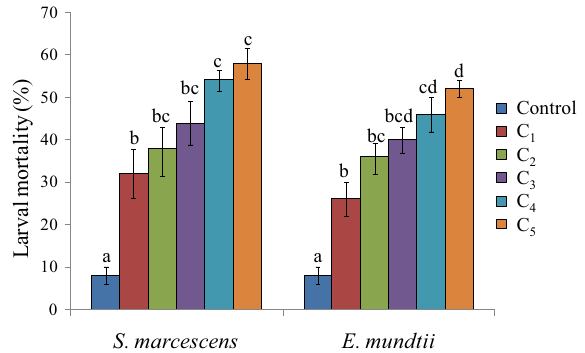
Figure 2. Influence of different concentrations of S. marcescens (C 1 = 2.6 × 10 8 cfu/ml, C 2 = 6.4 × 10 8 cfu/ml, C 3 = 1.6 × 10 9 cfu/ml, C 4 = 3.0 × 10 9 cfu/ml andC 5 = 5.2 × 10 9 cfu/ml) and E. mundtii (C 1 = 4.6 × 10 8 cfu/ml, C 2 = 8.9 × 10 8 cfu/ml, C 3 = 1.8 × 10 9 cfu/ml, C 4 = 3.4 × 10 9 cfu/ml and C 5 = 6.1 × 10 9 cfu/ml) on larval mortality of S. litura . Columns and bars represent the mean ± SE. Different letters above the columns represent significant differences at Tukey’s test p ≤ 0.05.